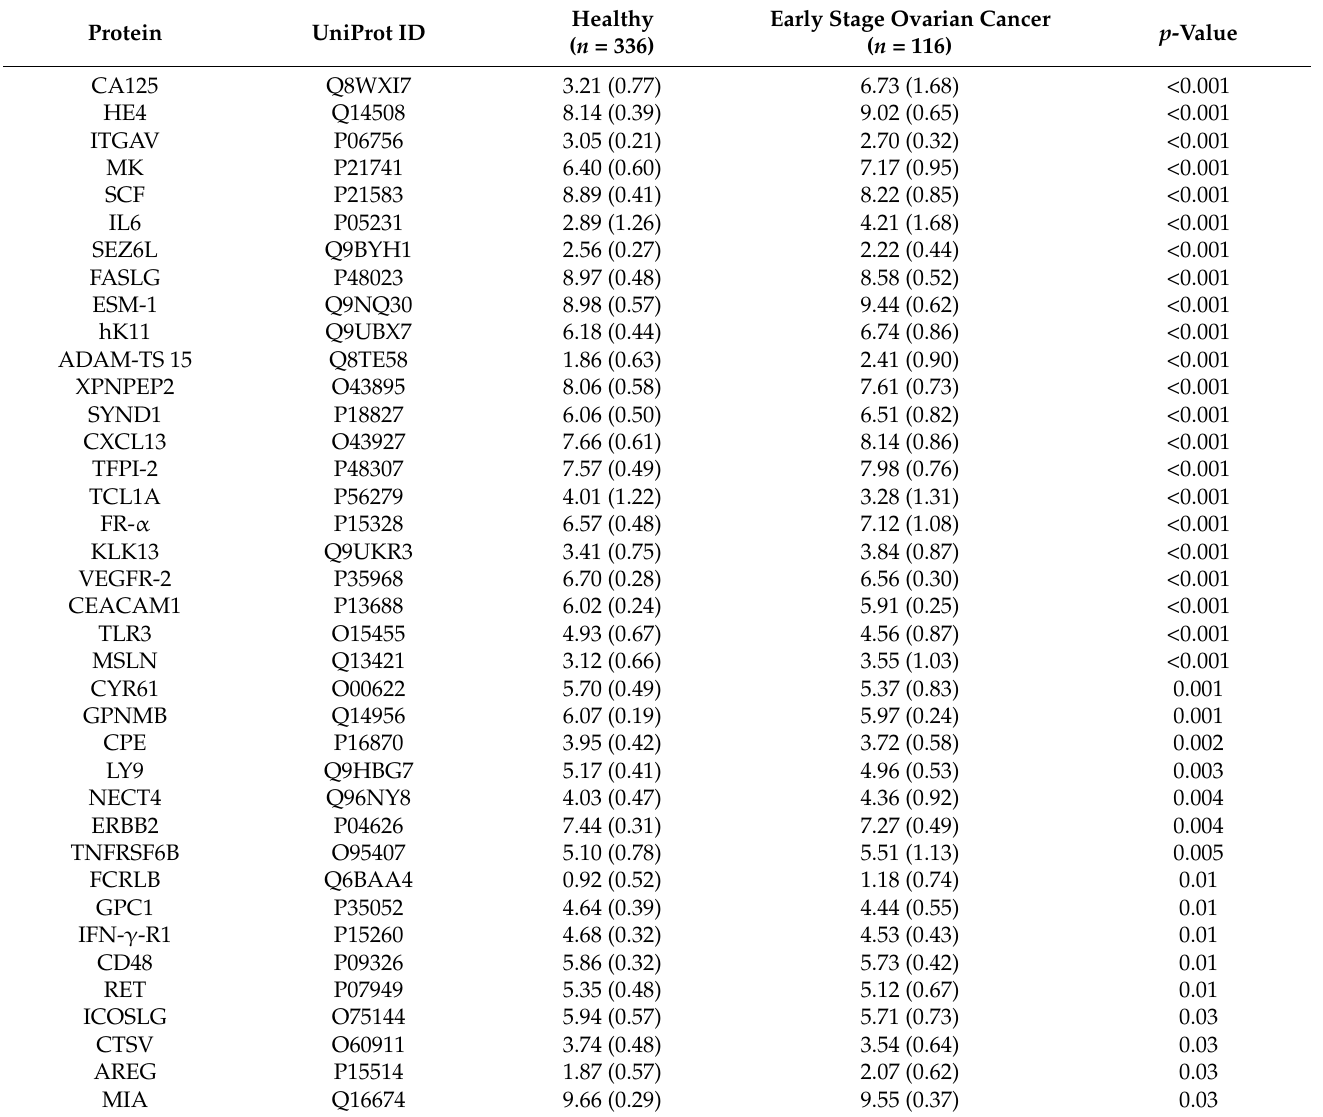
Table 2. Mean (standard deviation) of NPX values for the 38 proteins in Cohort #1 significantly different between ovarian cancer and healthy